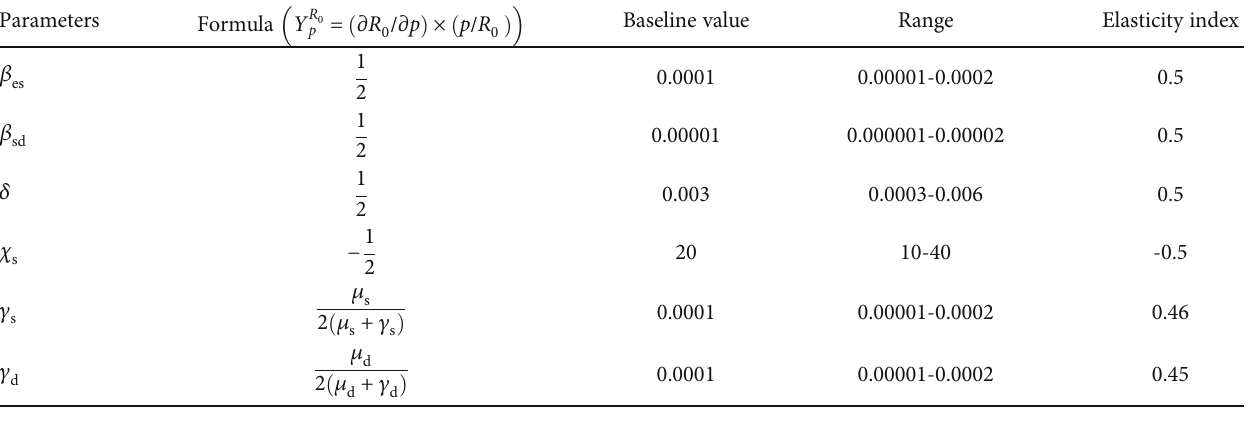
relative to some model parameters. 0